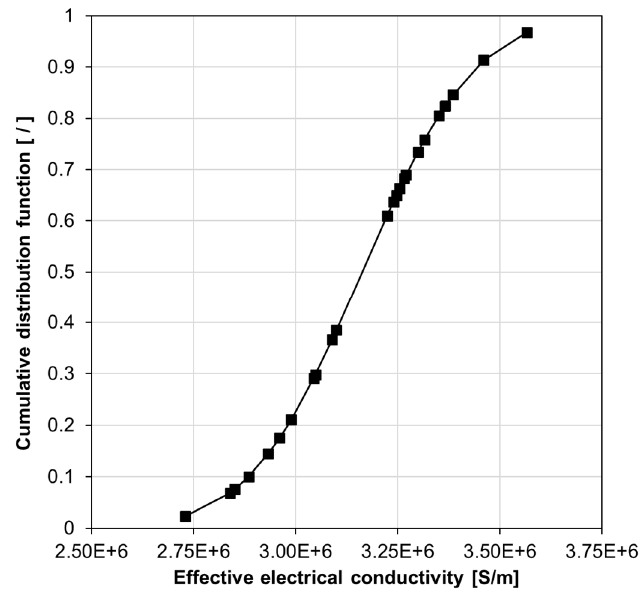
Figure 11. The cumulative distribution function for effective electrical conductivity data of a silver/epoxy nanocomposite system with a particle size of 3 nm, tunneling distance of 1.5 nm, and 30 vol% filler loading.